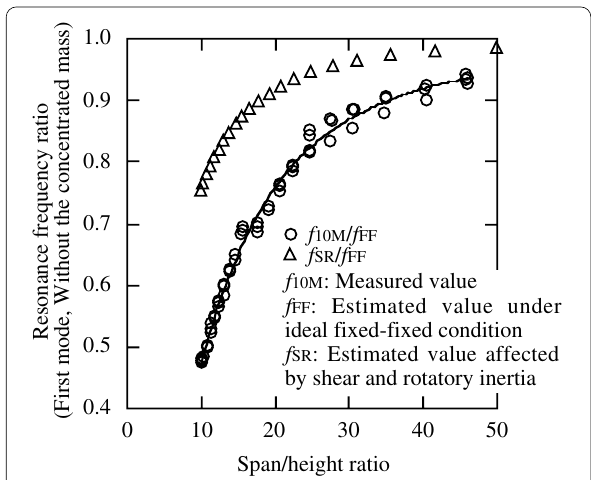
f 10M : Measured value f FF : Estimated value under ideal fixed-fixed condition f SR : Estimated value affected by shear and rotatory inertia